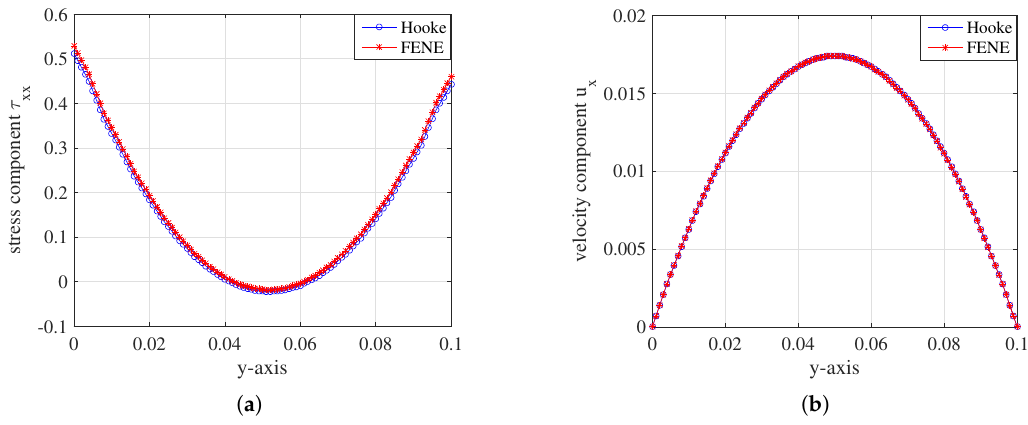
Figure 14. ( a ) Stress component τ xx ; and ( b ) velocity component u x on the y -axis during the steady state at t = 1.999185 for FENE model with the dumbbell’s extension parameter b = 100 and Hooke model.